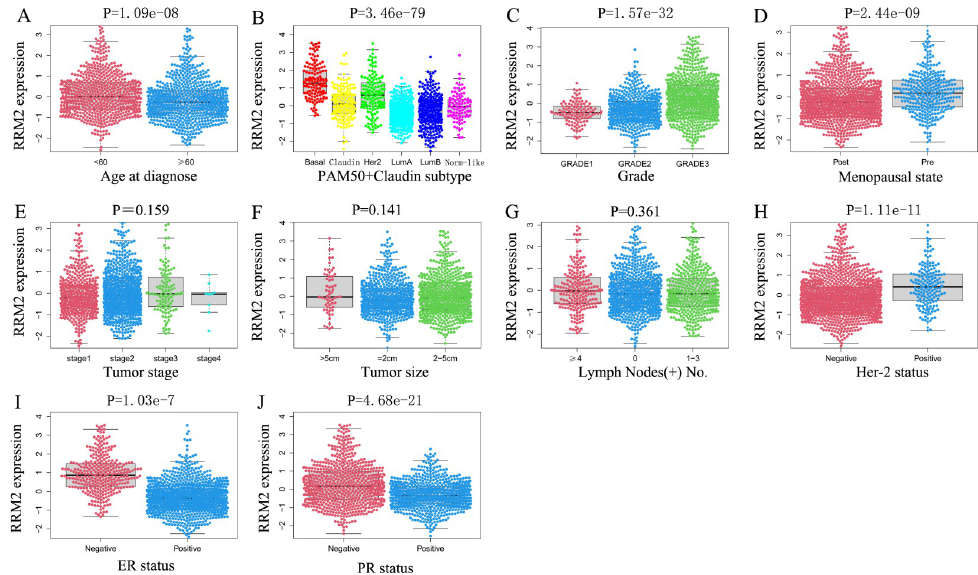
Fig 3. The scatter plot shows the expression of RRM2 in the clinicopathological characteristics of METABRIC. (A) Age; (B) Molecular subtype; (C) Grade; (D) Menopausal state; (E) Tumor stage; (F) Tumor size; (G) Lymph Node; (H) Her-2 status; (I) ER status; (J) PR status.